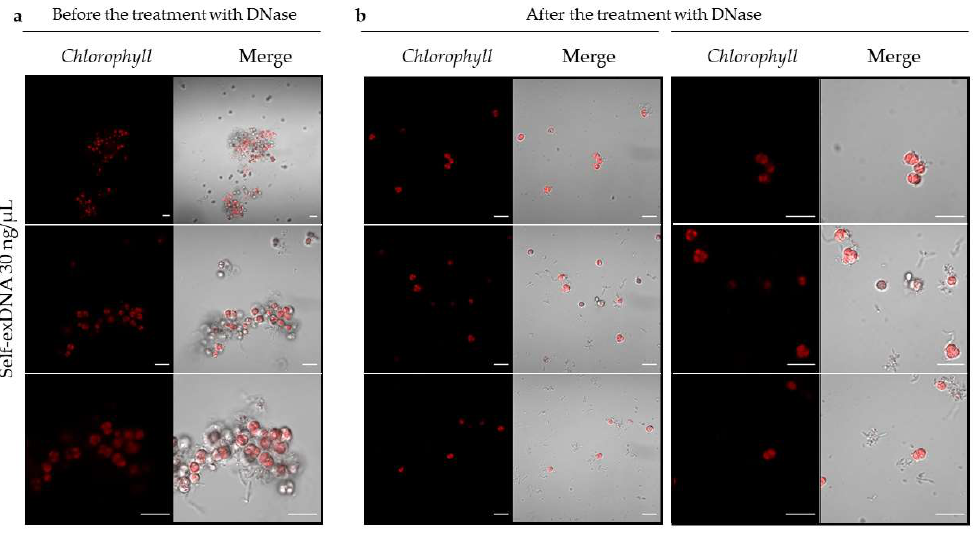
Figure 5. Microscopy analysis of C. reinhardtii aggregates after treatment with DNase. Aliquots of C. reinhardtii cells treated with self-exDNA at 30 ng/µL were observed before ( a ) and after the treatment ( b ) with 6 µL of 2.25 U/µL RNase-Free DNase (Qiagen) for 1 h. After treatments with DNase, cell aggregates break down. In red, the chlorophyll autofluorescence is shown (Ex/Em: 405/300–800). Microscope: Zeiss LSM 700, Oberkochen, Germany; excitation at 405 and detection in the range 300–800; objective: 63× 1.40 Oil Dic; scale bar = 10 µm.